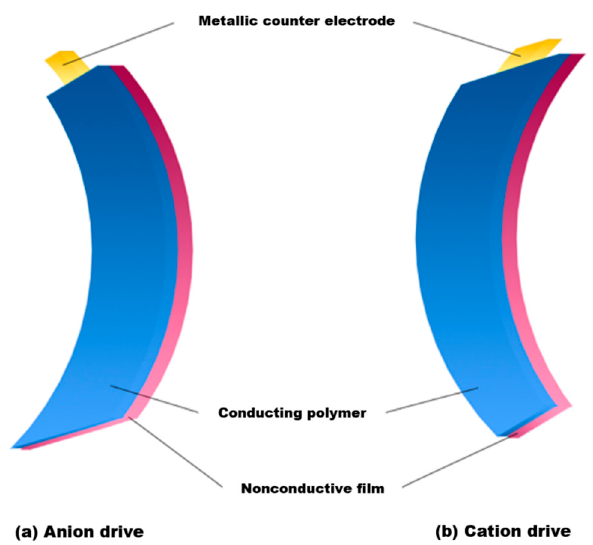
Figure 7. A bilayer actuator bends upon oxidation of the CP: anion-driven swelling results in the CP layer on the concave side ( a ), whereas cation-driven shrinking results in the CP layer on the convex side when the CP is reduced ( b ).